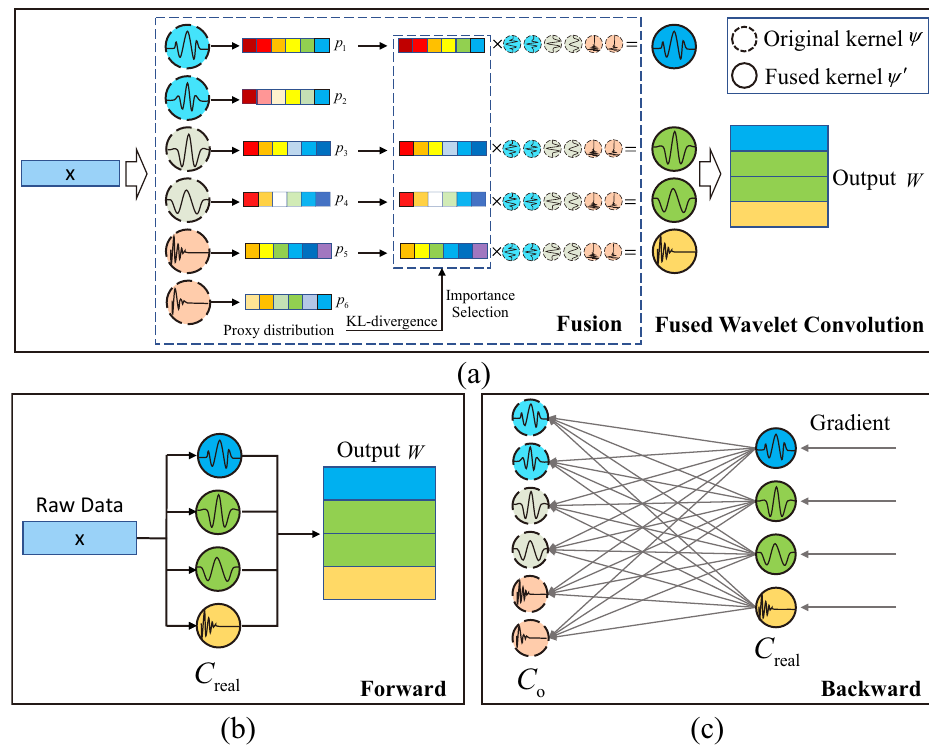
Figure 6 Fused wavelet convolution: a New wavelet kernels fused from the original wavelet kernels and used for convolution; b Data flow in forward propagation (the fused new kernels are used); c Gradient flow in backpropagation (gradient is back propagated to all original